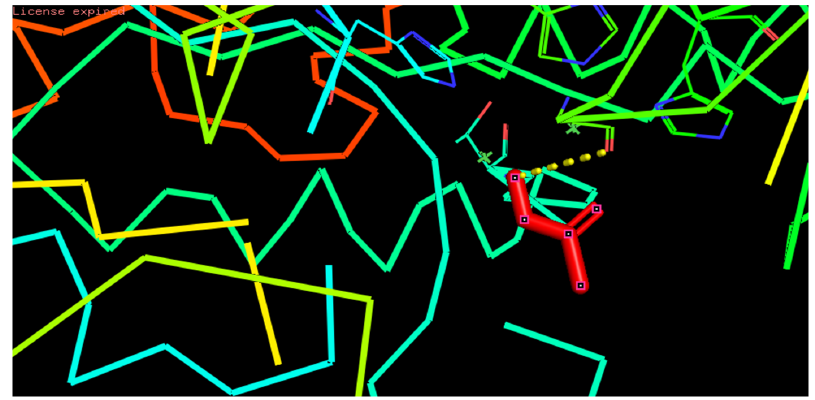
Figure 1. H. pylori urease enzyme in a 3D image with the ligand AHA cut off.